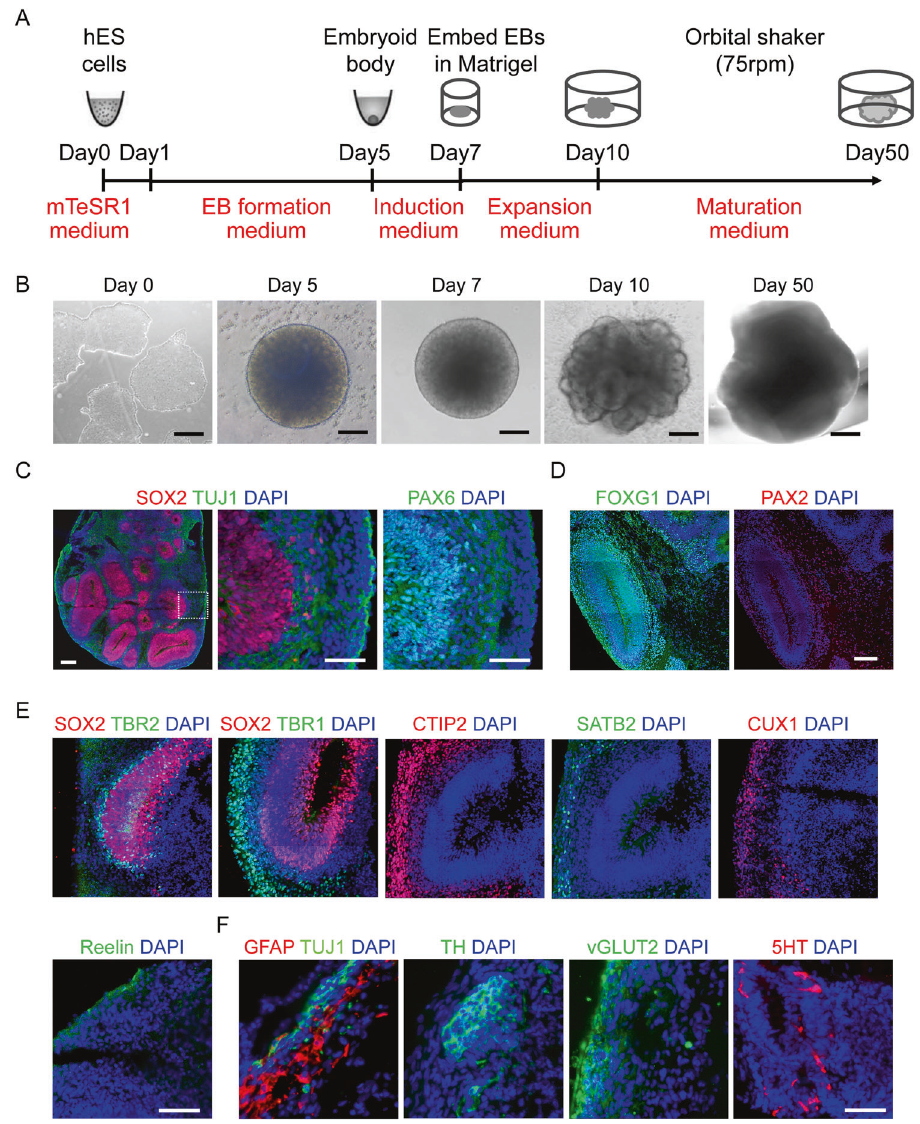
Fig. 2 Establishment of mature BOs with hPSC. A A schematic overview of the procedures for generating BOs from hPSCs using the STEMdiff ™ Cerebral Organoid Kit. B Representative images of hPSC-derived cells at the corresponding stages. C Representative images of the ventricular zone-like structure formed by new-born neurons (Tuj1 + ) and neural progenitor cells (SOX2 and PAX6 + ) in BOs at day 40. Scale bar: 100 μ m. D Representative images of the positive staining regions for forebrain (FOXG1) and hindbrain (PAX2) markers respectively. Scale bar: 100 μ m. E Representative images showed the immunostaining of the six layers of cortical neurons at day 60. Scale bar: 100 μ m. F Confocal images showed the positive staining regions for the astrocyte markers GFAP, and the expression of different subtypes of functional neuron markers, such as TH, 5-HT and vGLUT2. Scale bar: 100 μ